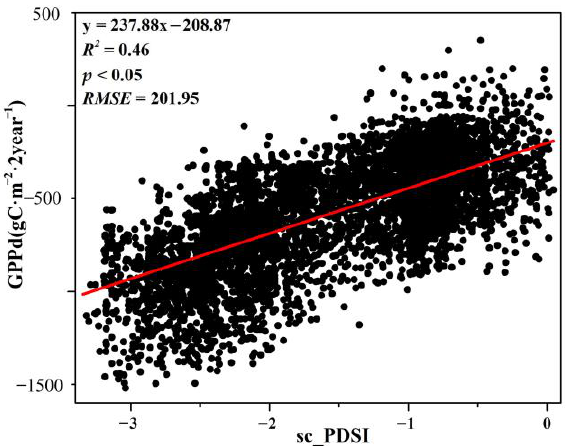
Figure 15. Scatter plot of the total value of GPPd and the mean value of sc_PDSI in all months, 2009- 06 –